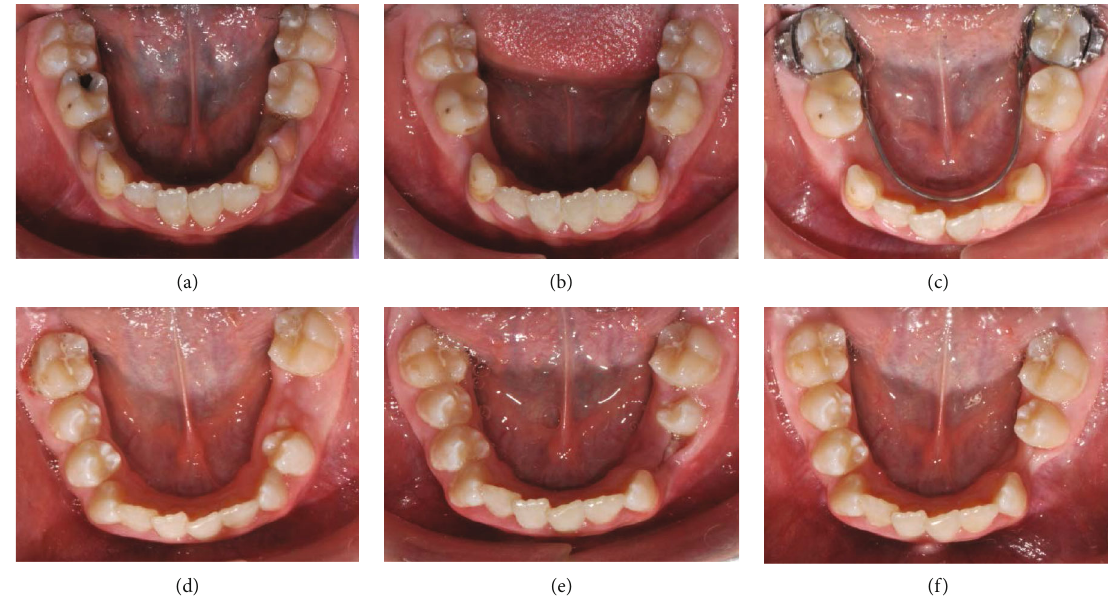
Figure 7: Development of the lower dental arch. (a) Initial state. (b) After extraction of temporary fi rst molars. (c) Placed lingual arch. (d) Eruption of the lower right fi rst and second premolars and left fi rst premolar — double tooth. (e) Spontaneous eruption of the lower left second premolar, after extraction of tooth 34. (f) Complete eruption of the lower left second premolar.